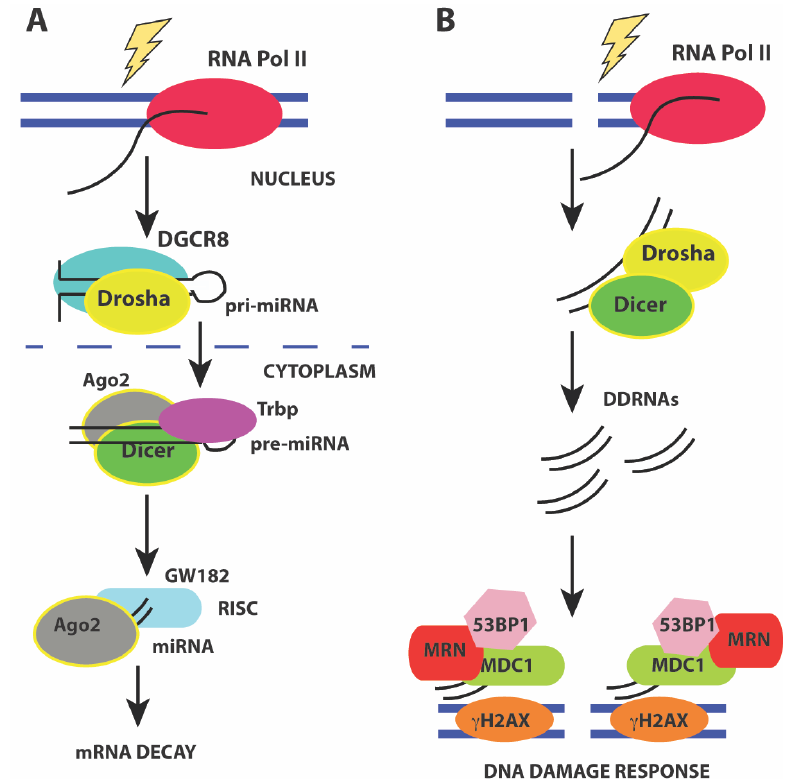
Figure 4. ( A ) pathway of miRNA processing to regulate mRNA decay. Pri-miRNA precursors are transcribed and processed before assembling into a macromolecular complex containing the Drosha/DGCR8 heterodimer to release a ~70 nt pre-miRNA hairpin in the nucleus. The pre-miRNA hairpin is exported to the cytoplasm by XPO5 and Ran-GTP. In the cytoplasm, the pre-miRNA hairpin is cleaved by Dicer to generate the mature ~22 nt miRNA duplex that associates with Ago2 leading to the formation of the RNA-induced silencing complex (RISC). Activation of mRNA decay results in base-pairing of the guide strand to the mRNA 3 ’ UTR and recruitment of mRNA decay factors such as GW182; ( B ) Activation of the DNA damage response by DDRNAs also involves miRNA processing factors Drosha and Dicer that are required to generate small ~20 – 35 nt RNAs from the sequences around the site of damage. Formation of DNA damage foci and recruitment of DNA damage factors requires DDRNAs, Drosha, and Dicer.